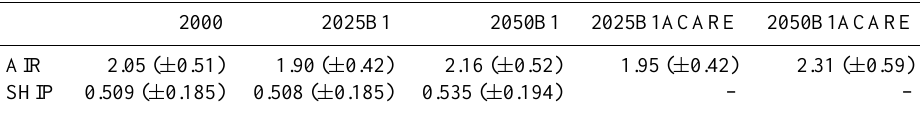
Table 3. Global annual average of the change in O 3 molecules per NO x molecule emitted from aviation and shipping, given as ensemble means and standard